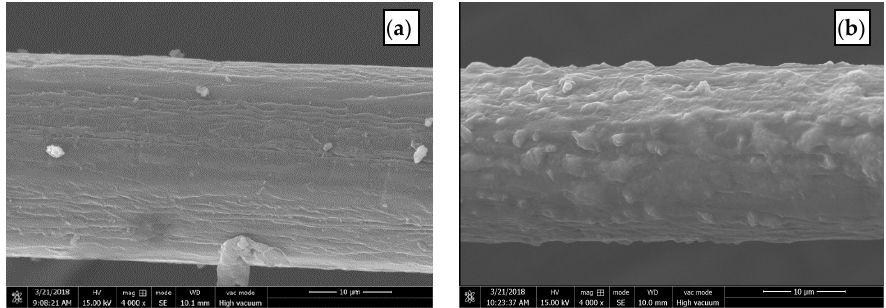
Figure 4. SEM images of the surface morphology of BF: ( a ) untreated; ( b ) RES-treated.